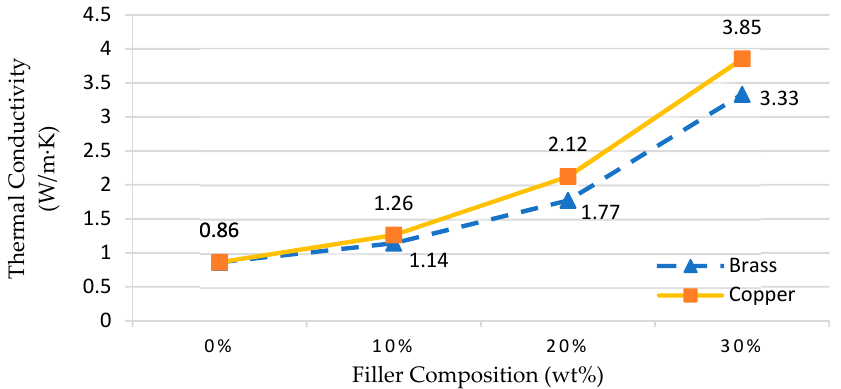
Figure 7. Effects of fillers on thermal conductivity.